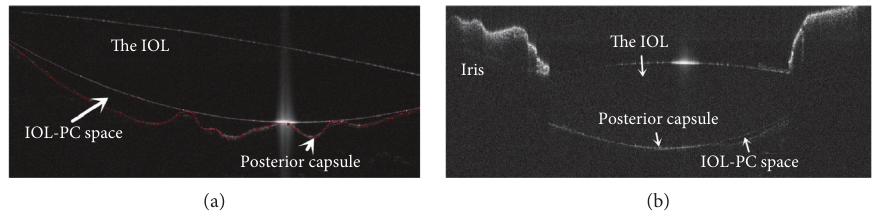
Figure 1: The UL-OCTdetects the boundaries of intraocular lens (IOL), posterior capsule (PC), and the space between IOL and posterior capsule (IOL-PC space). (a) The ZCB00 IOL. (b) The Softec HD IOL. UL-OCT � ultralong scan depth spectral-domain optical coherence tomography.